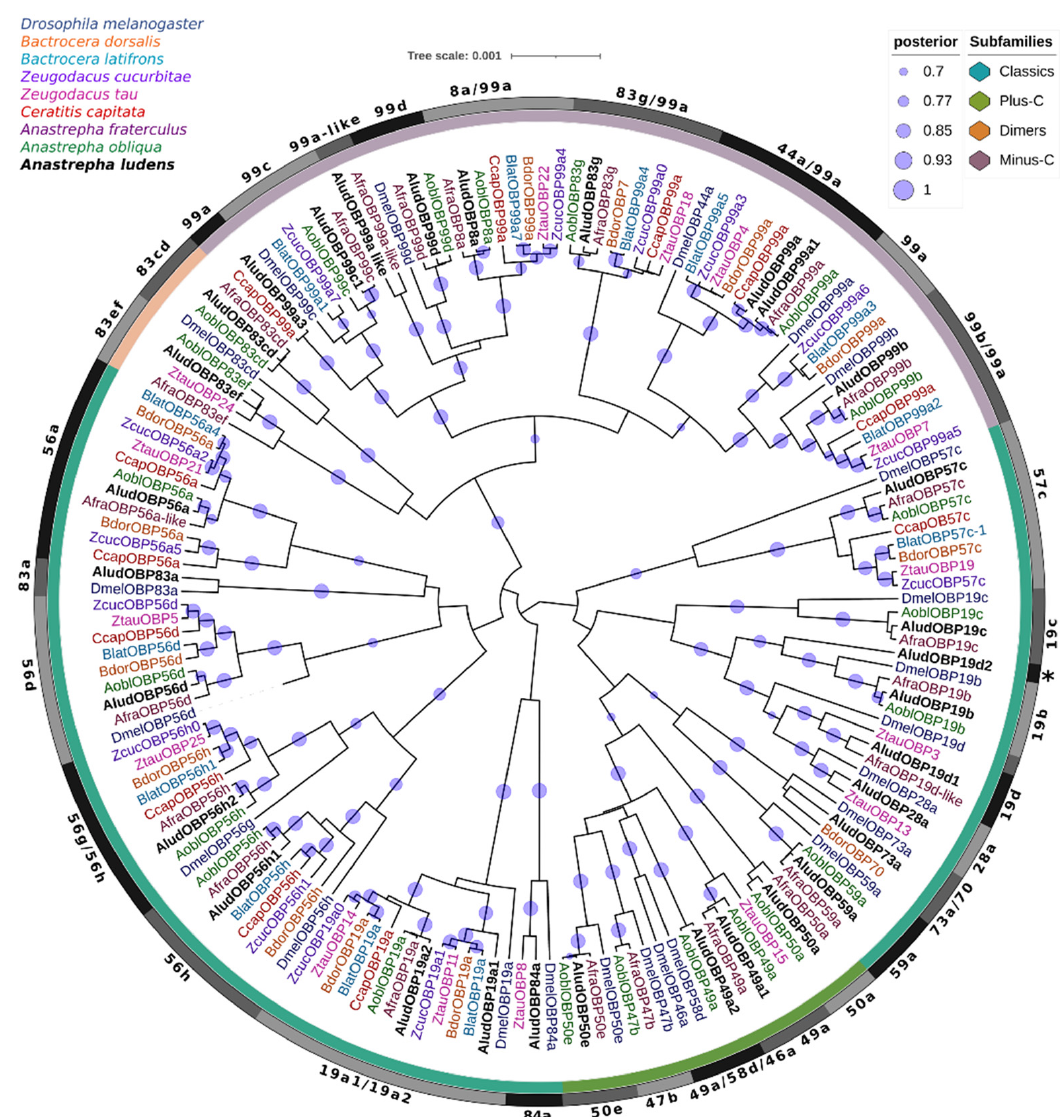
Figure 2. Bayesian phylogenetic analysis of candidate OBPs from Anastrepha ludens with homologs from seven Tephritidae species and the model organism Drosophila melanogaster . The clusters of subfamily OBPs identified in AludOBPs have distinct color bar marks. Gray bars delimit the branch expansions of the AludOBPs and their orthologues. Circles showed posterior probability values higher than 70%.